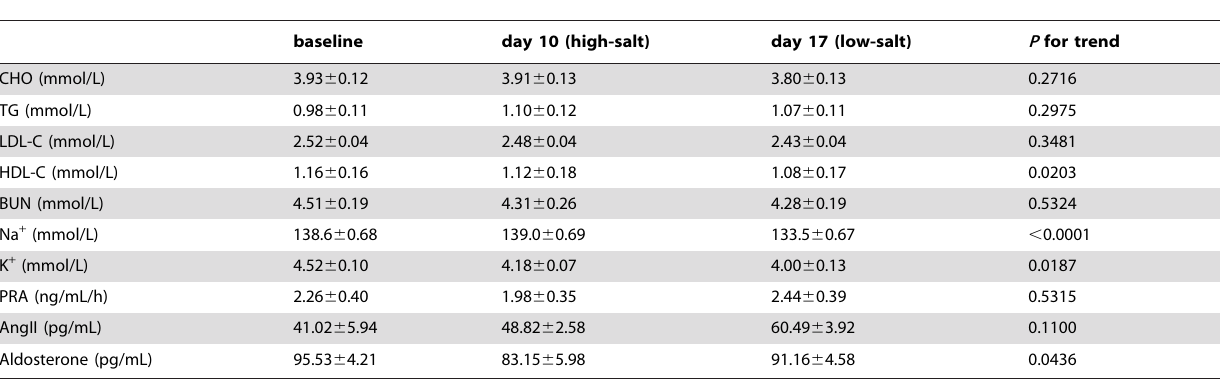
Table 5. Serum/Plasma Biochemical Changes During Dietary Intervention